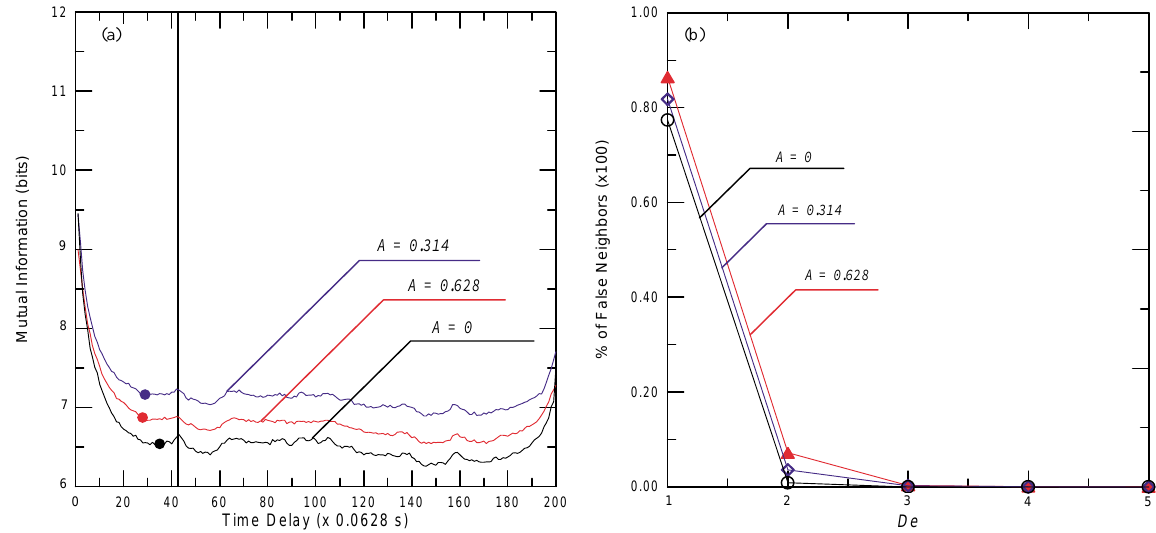
Fig. 5. Chaotic signal. (a) Mutual information versus time delay; (b) Percentage of false Neighbors versus embedding